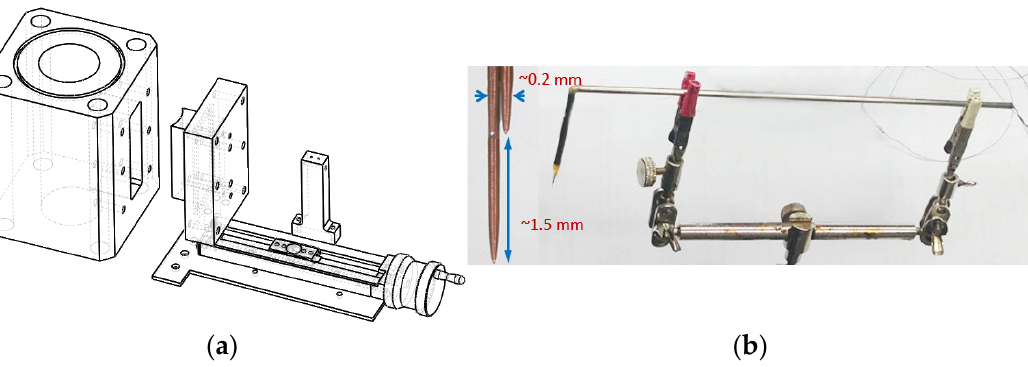
Figure 2. ( a ) Instrumentation port for pressure and probe measurement and flow visualization, ( b ) Four ‐ sensor conductivity probe.